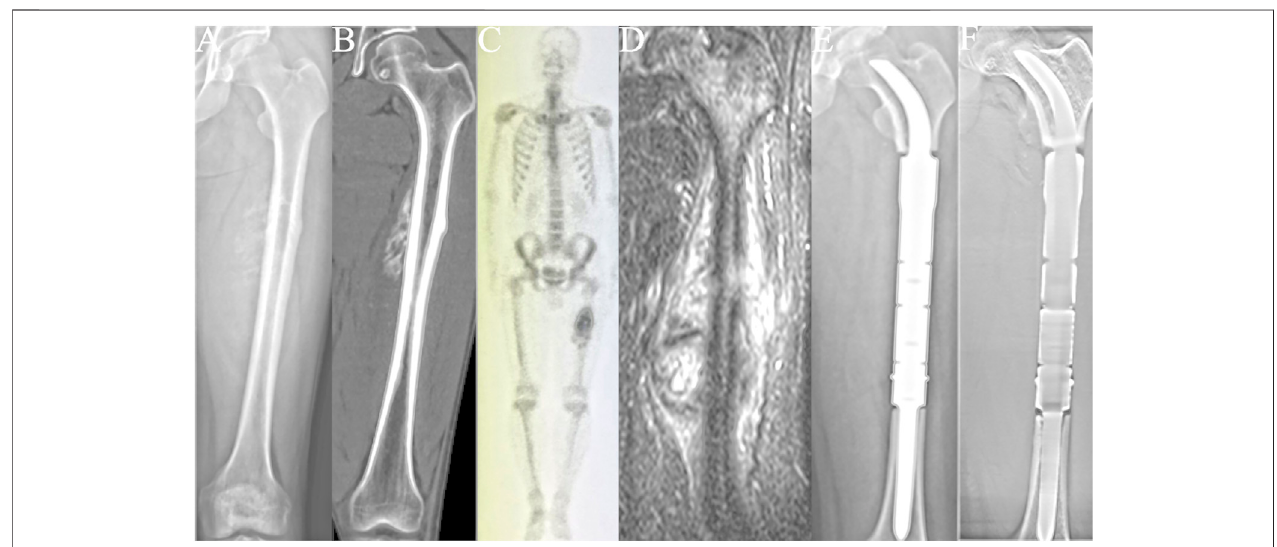
FIGURE 1 | All patients underwent en bloc tumor resection followed by reconstruction with the customized cementless intercalary endoprosthesis with an intra-neck curved stem. (A) Anteroposterior radiograph of the left femur of a patient with a femoral diaphyseal osteosarcoma. (B) Computed tomography (CT) image of theleftfemur. (C) Single-photonemissionwhole-bodyCTimage. (D) Magneticresonanceimageofthepatient ’ sleftupperleg. (E) Postoperativeradiographofthefemur. (F) Postoperative tomosynthesis with Shimadzu Metal Artefact Reduction Technology (T-smart) of the femur 7 days after surgery showing stable femoral diaphyseal